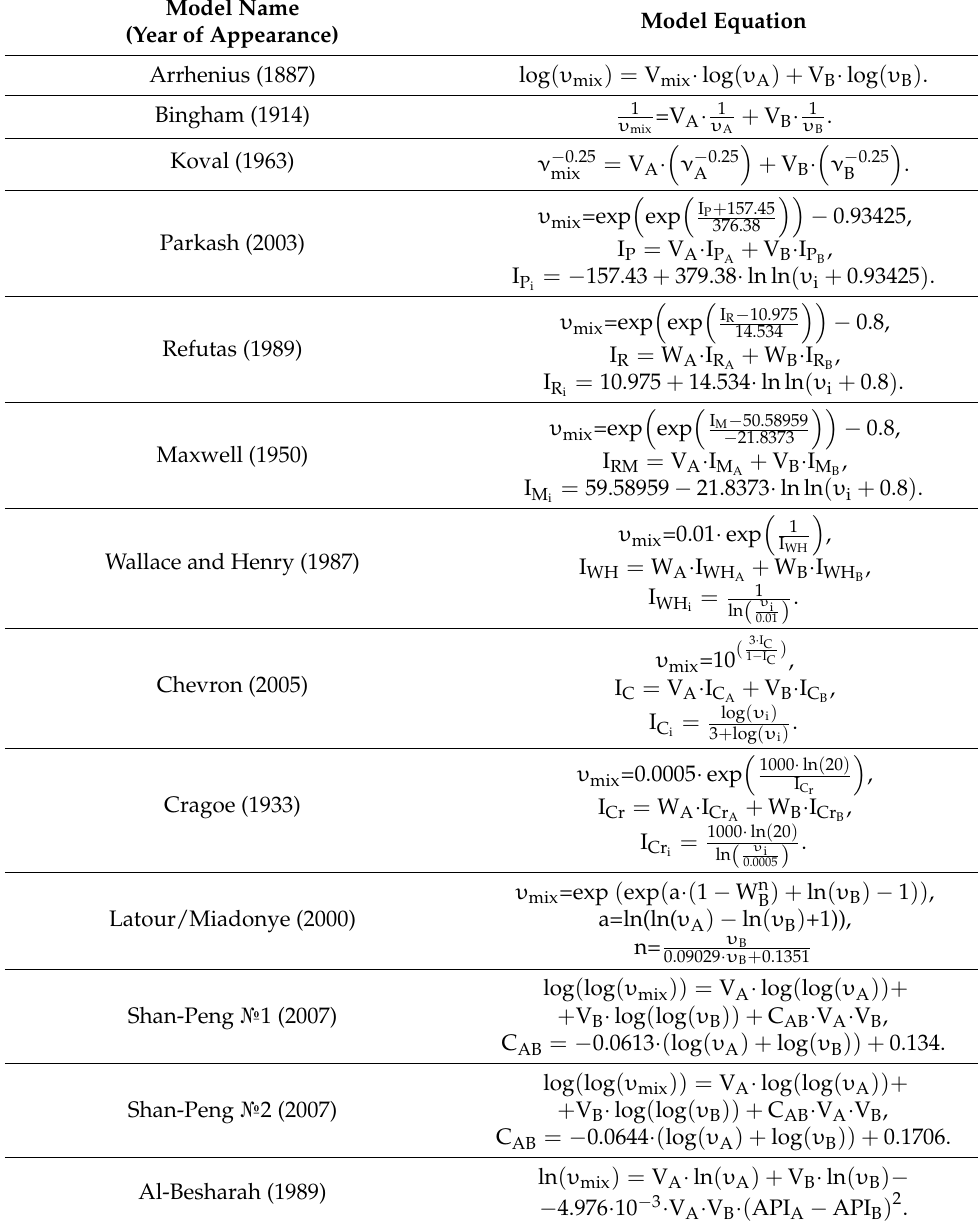
Table 6. Models for determining the viscosity of binary oil mixtures